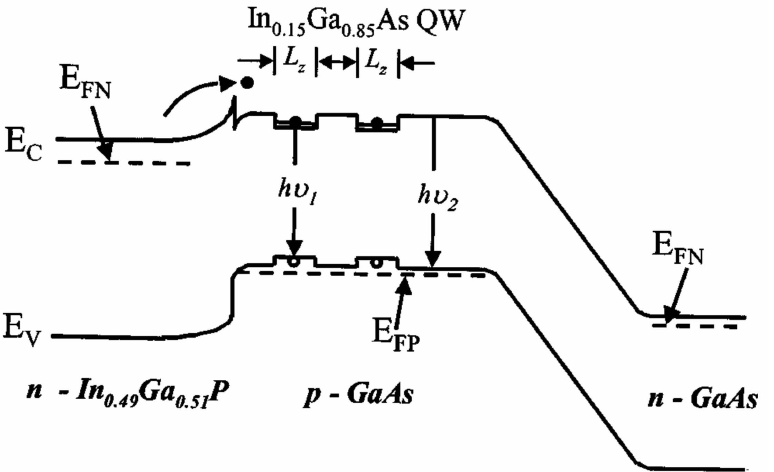
Figure 1. Two 5 nm InGaAs QWs are embedded in the p-type GaAs base region, which enhances the carrier confinement and radiative recombination ability of the base region. This can achieve both electrical gain and optical gain